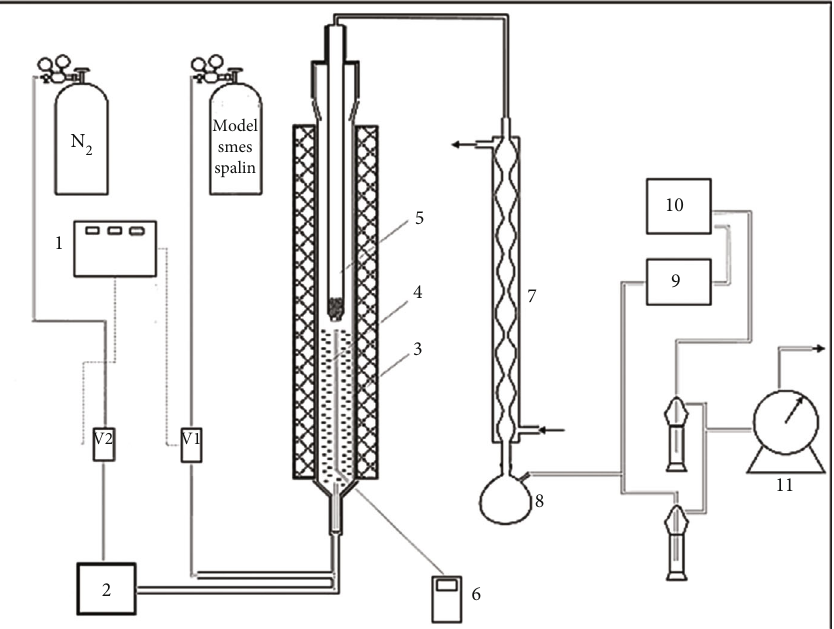
Figure 1: Experimental apparatus. 1 — control unit, 2 — analyser, 3 — reactor, 4 — crushed quartz, 5 — quartz reactor with the sample, 6 — thermometer, 7 — water cooler, 8 — condensate trap, 9 — cooling unit, 10 — analyser, 11 — gasometer, V1 and V2 — control